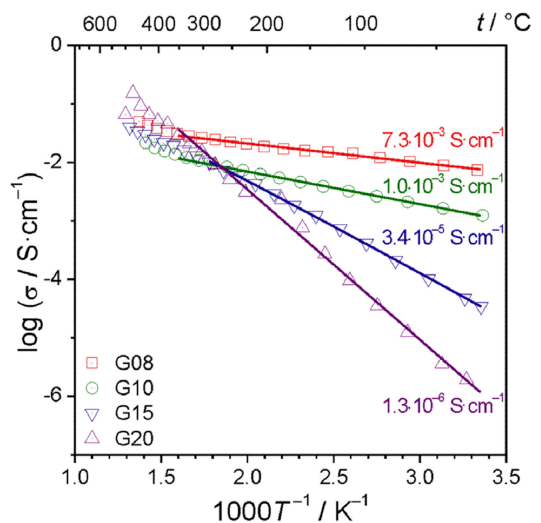
Figure 12. Temperature dependences of the electrical conductivity of the nanocrystallized glasses of the Li 2 O–FeO–V 2 O 5 –P 2 O 5 system: G08 (LiFe 0.80 V 0.08 PO 4 ), G10 (LiFe 0.75 V 0.10 PO 4 ), G15 (LiFe 0.625 V 0.15 PO 4 ) and G20 (LiFe 0.50 V 0.20 PO 4 ). (Reproduced with permission from ref. [48]. Copy- right 2016,